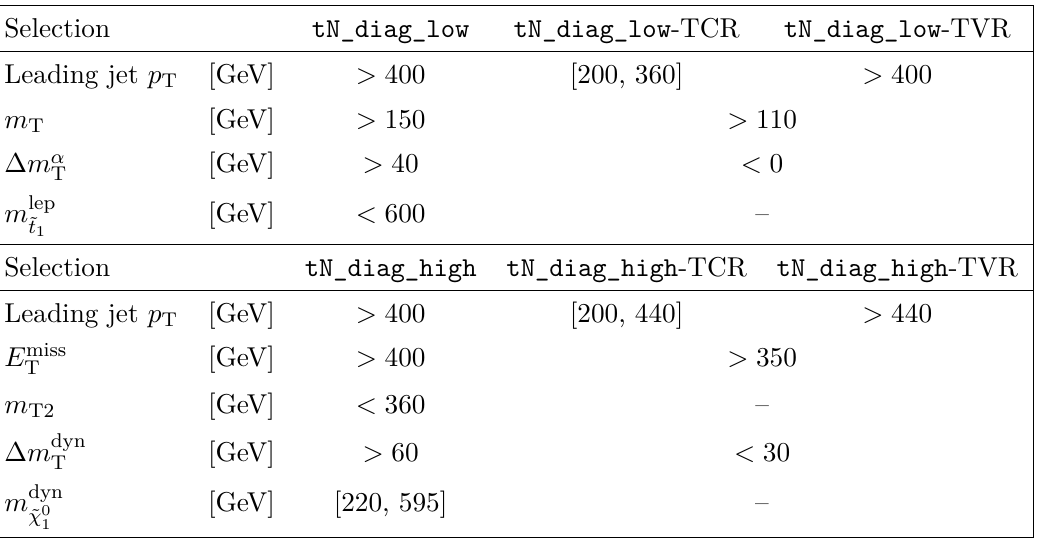
Table 11. Event selections defining the tN_diag_low and tN_diag_high TCR and TVR relative to their respective signal